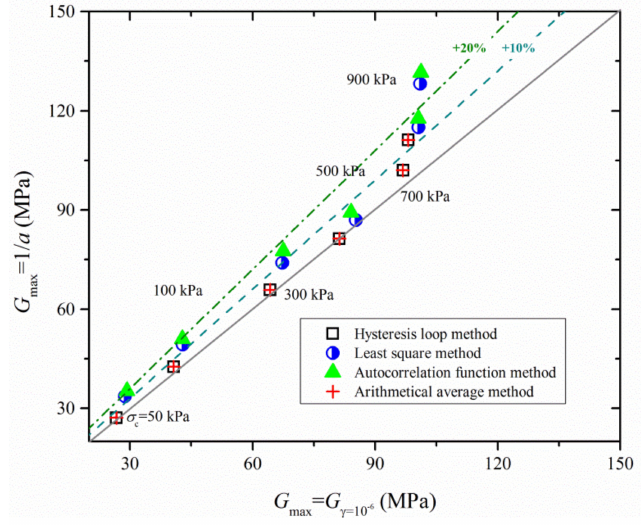
Figure 13. Comparison of G max between 1/ a and G γ =10 − 6 . The previous discussion has highlighted the effects of different definitions on G max . The discrepancy observed in the G max will influence the corresponding G / G max